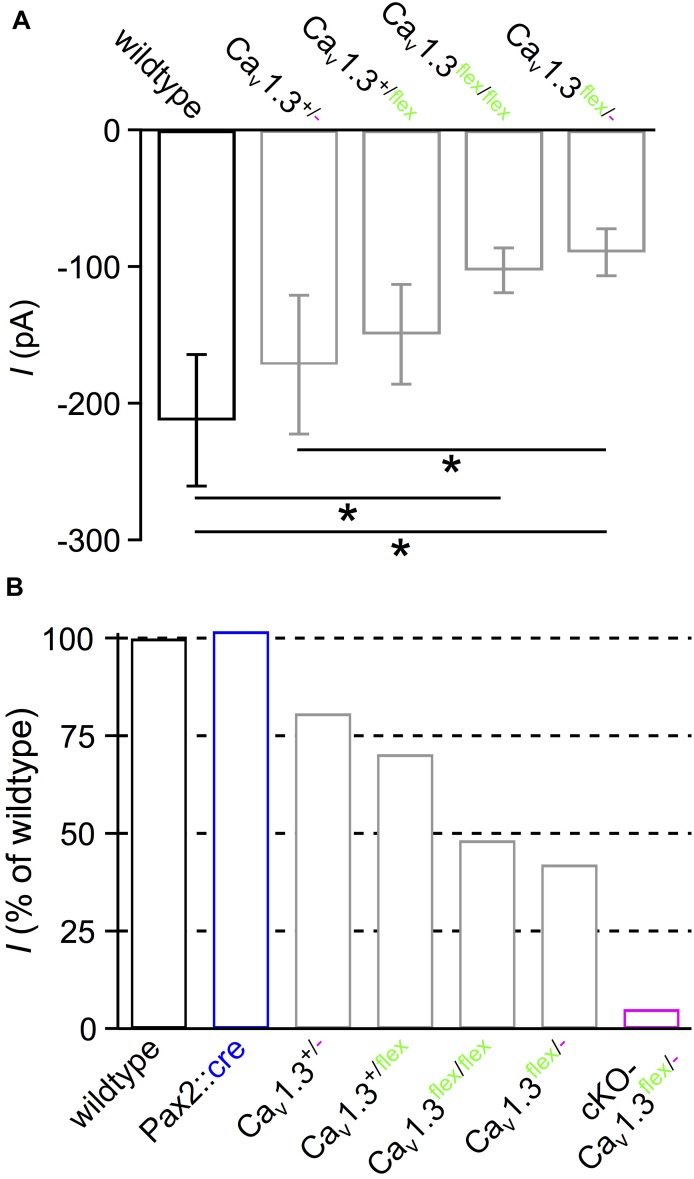
Reduced IBa amplitude in IHCs with unswitched flex alleles. (A) Averaged peak IBa ± SD of 10 wildtype, 10 Cav1.3+/-, 7 Cav1.3+/flex, 10 Cav1.3flex/flex and 10 Cav1.3flex/- IHCs reveal that IBa was reduced when at least one wildtype allele was replaced by a flex allele (∗ effect of genotype; P < 0.001, Kruskal–Wallis Test). (B) Percentage of average peak IBa of IHC groups from panel (A), 10 Pax2::cre controls and 15 cKO-Cav1.3flex/- IHCs (Figure 2E), all normalized to the wildtype (100%).